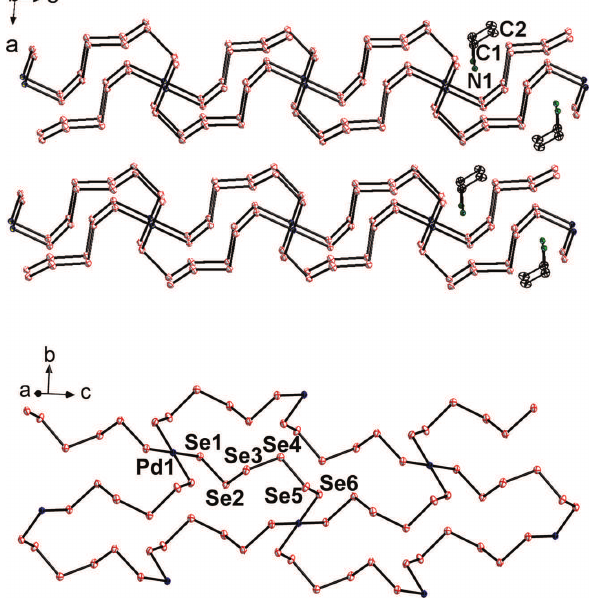
Table 1: Data collection and handling.